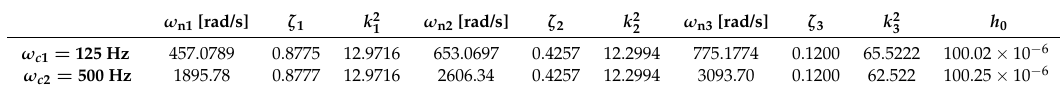
Table 1. Dynamical parameters of the two identified sixth-order elliptic